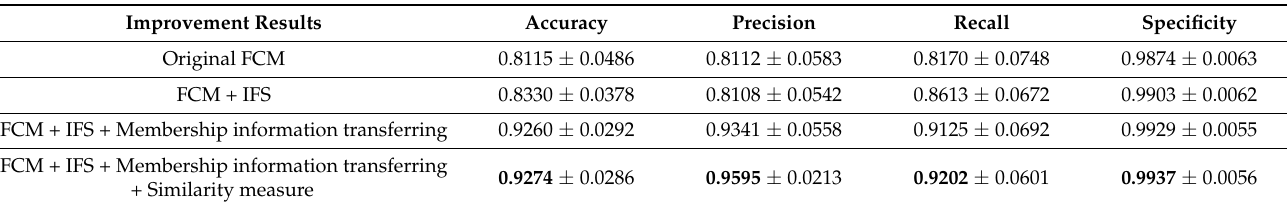
Table 2. Average values of the ablation experiments (mean ± standard deviation). FCM Fuzzy C-means algorithm and IFS: intuitionistic fuzzy